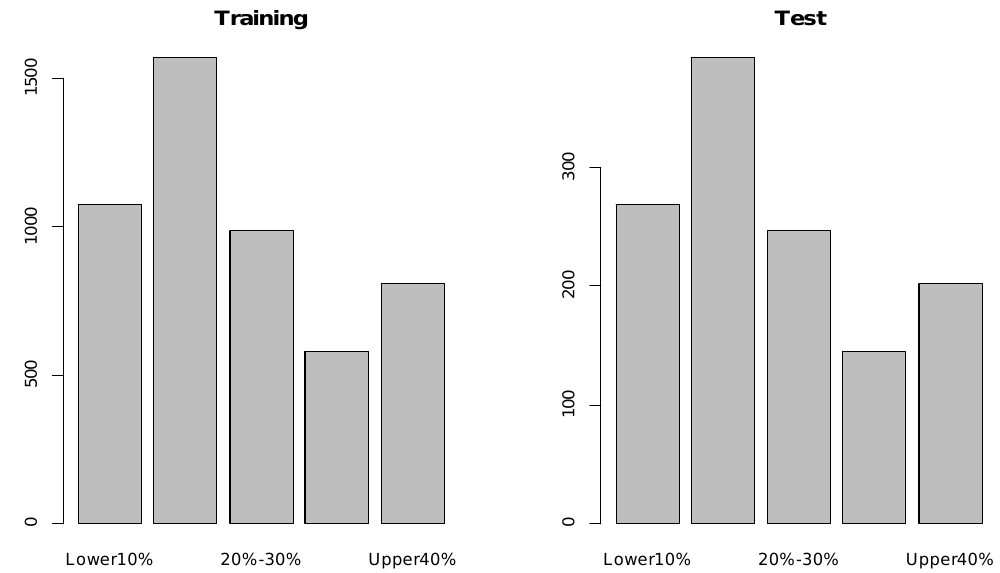
Figure 2. Frequencies of the catastrophic rate in the training and test groups.